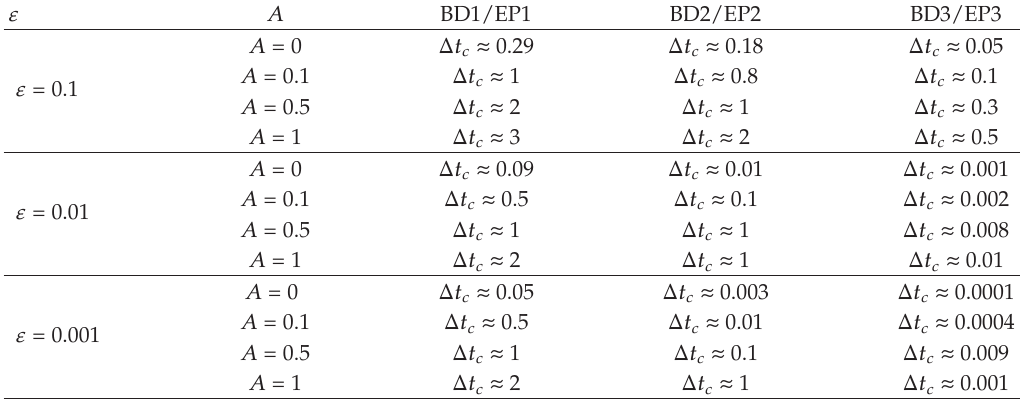
Table 1: Stability comparison with di ff erent A and ε when λ (cid:6) ε .